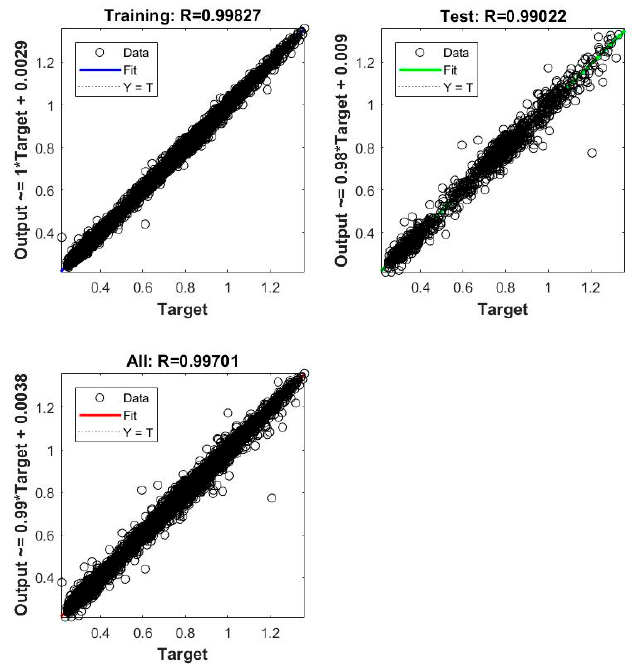
Figure 12. The regressions between the network targets and network outputs when forecasting the electricity consumption for the month of December, using the ANN_NARX_BR_ALL network.